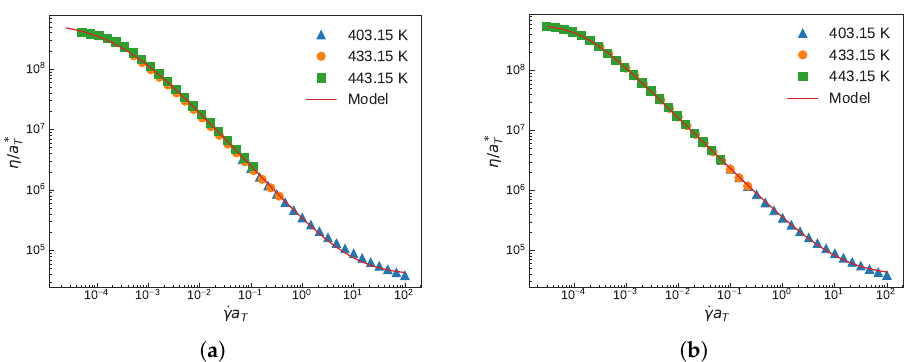
Figure 4. Master curve and the corresponding Carreau–Yasuda fit obtained by: ( a ) traditional approach; and ( b ) Scenario 1.